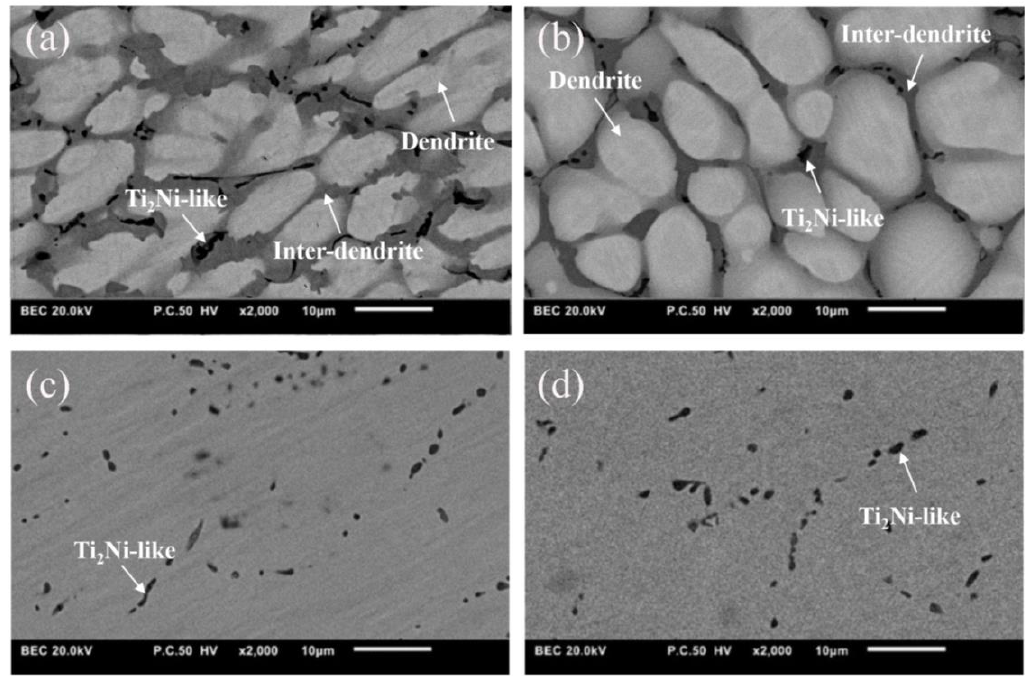
Figure 1. Microstructure of as-cast states ( a ) Cu15HZ25 and ( b ) Cu15HZ30; microstructure of as- homogenized states ( c ) HCu15HZ25 and ( d ) HCu15HZ30. Table 1. EDS analysis of Cu15HZ25 and Cu15HZ30 in as-cast and as-homogenized states.